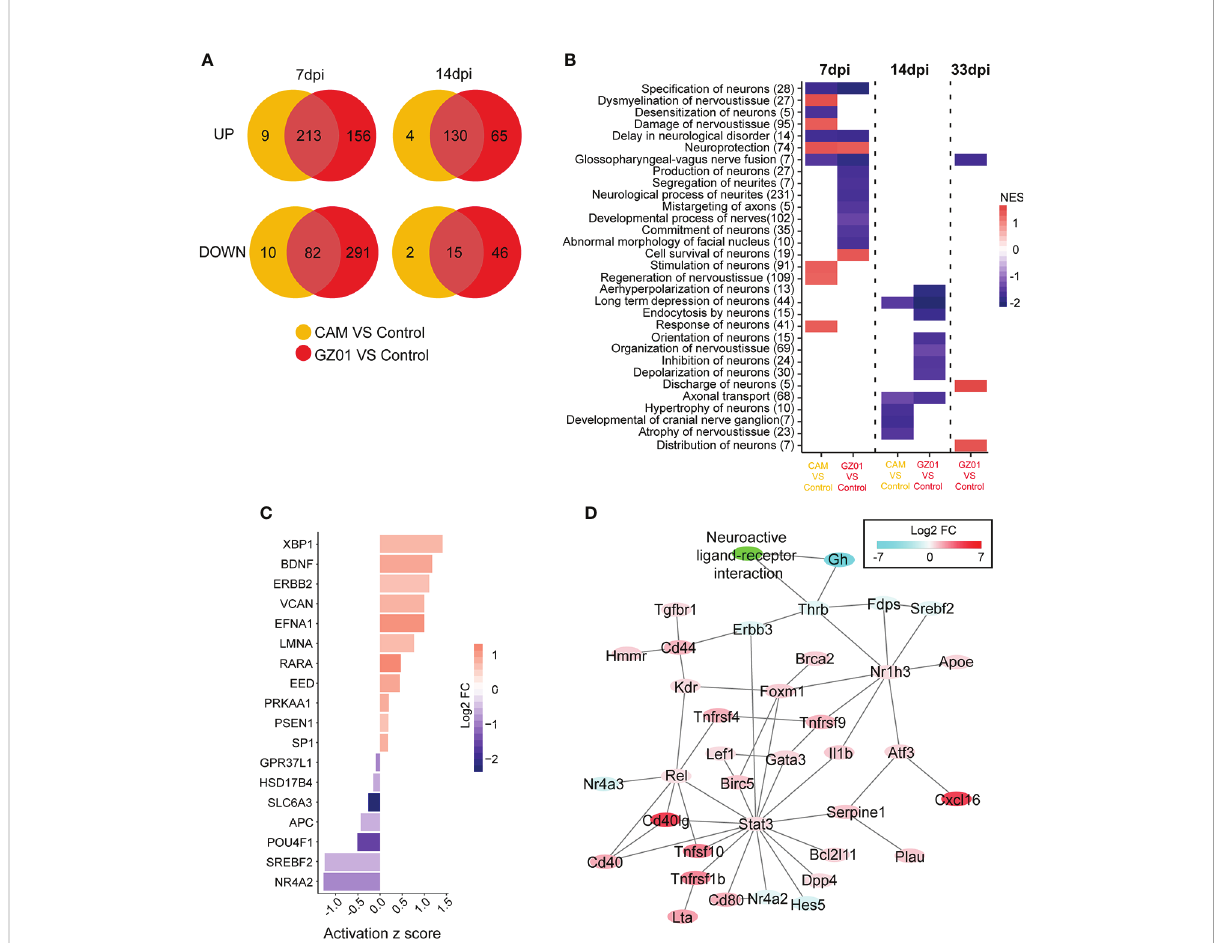
FIGURE 5 Characteristics of neurological disturbance in different infection groups. (A) , The common and speci fi c gene numbers between GZ01 and CAM infections are shown in the Venn diagram. (B) , GSEA scores of neurological gene set in different comparison groups. (C) , Upstream regulatory factors for GZ01-speci fi c genes related to neurological function at 7 dpi. (D) , Regulatory network based on GZ01-speci fi c differentially expressed neural genes at 14